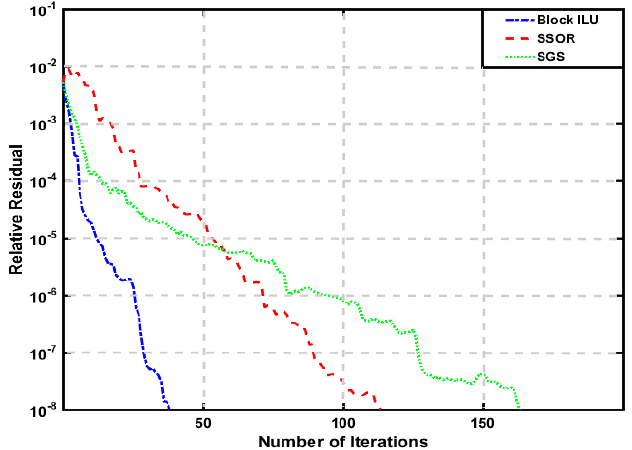
Figure 7. The convergence plot of various preconditioners with BiCGStab for marine model 2. Appl. Sci. 2019 , 9 , 1328